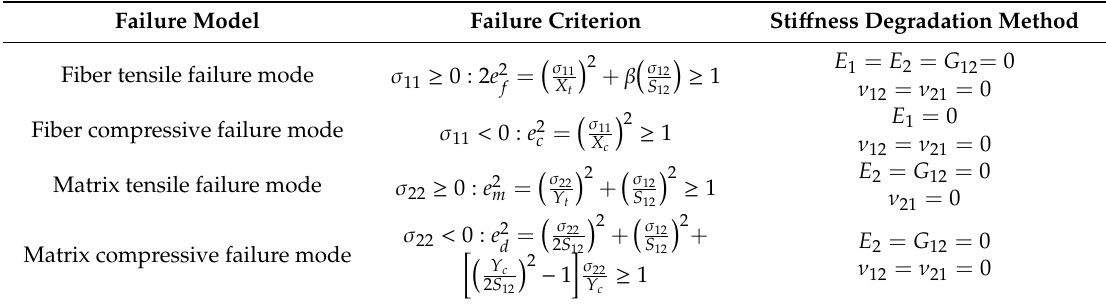
Table 2. Chang–Chang failure criterion and sti ff ness degradation method used in this work.